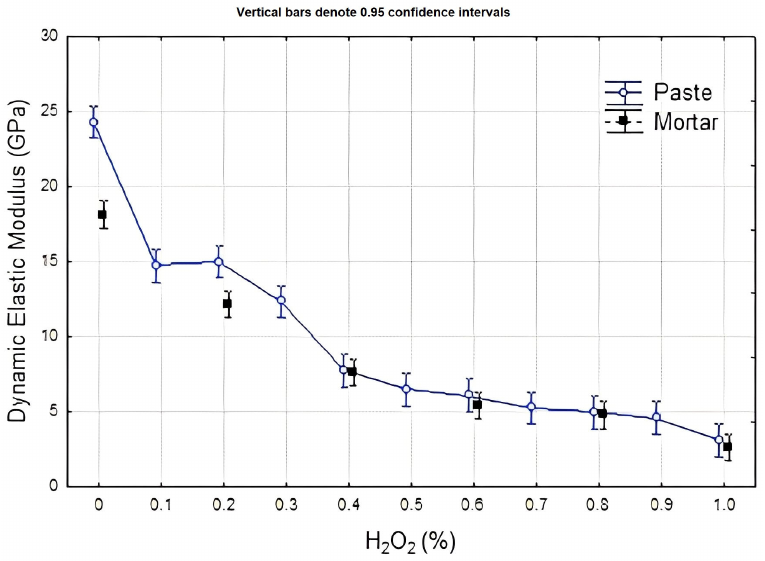
Figure 6. Effect of H 2 O 2 concentration on the dynamic elastic modulus of the geopolymer. Figure 6. E ff ect of H 2 O 2 concentration on the dynamic elastic modulus of the geopolymer.